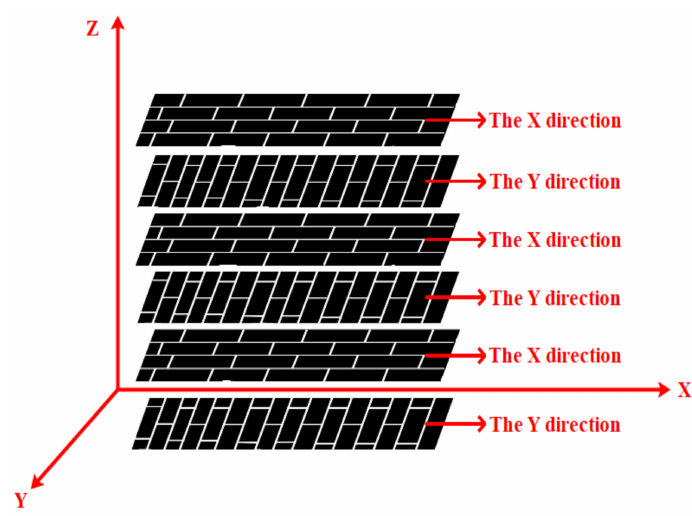
Figure 3. Schematic diagram of layering [XYXYXY]